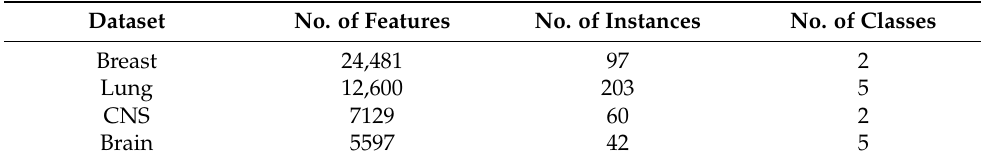
Table 1. Description of the high-dimensional microarray datasets used in this study. Dataset No. of Features No. of Instances No. of Classes Breast 24,481 97 Lung 12,600 203 CNS 7129 Brain 5597